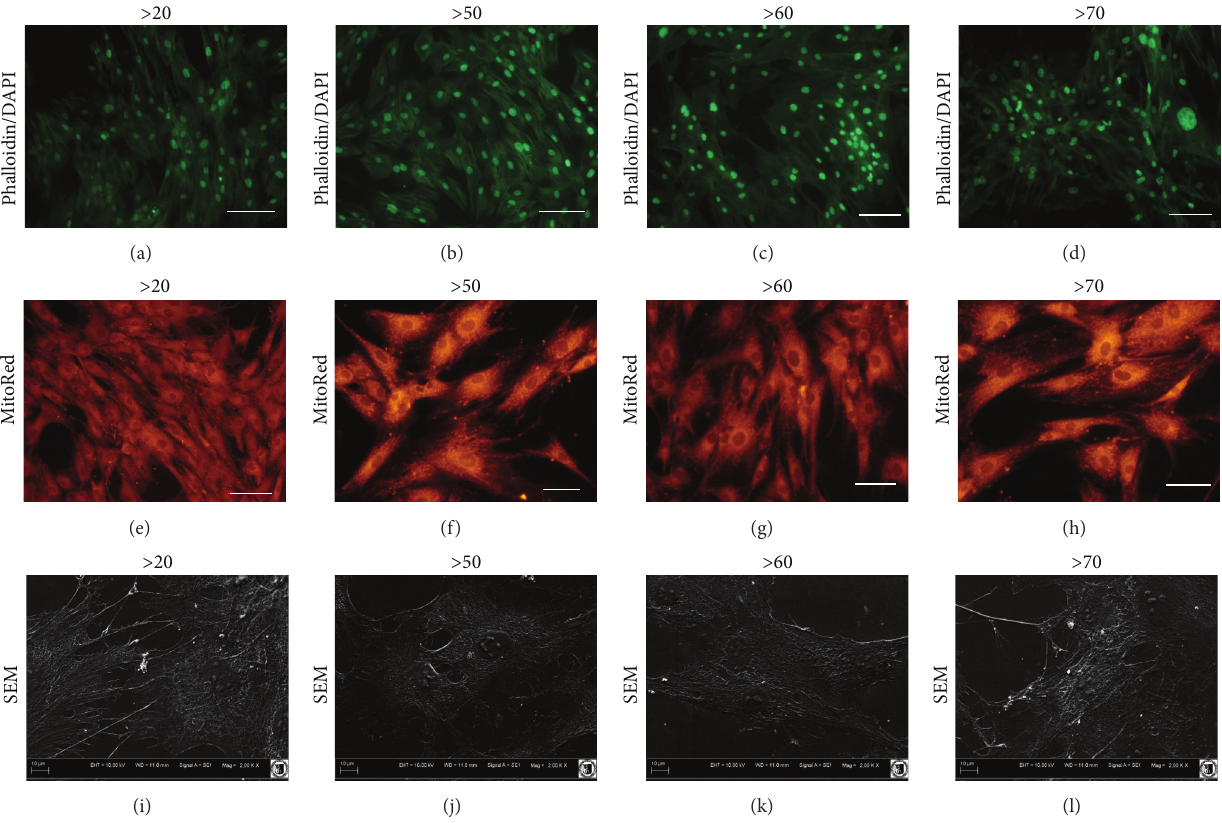
Figure 2: Comparison of hASCs morphology from different age groups, evaluated after seven days of propagation. Scale bars: (a–d) 250 𝜇 m; (e–h) 300 𝜇 m; (i–l) 10 𝜇